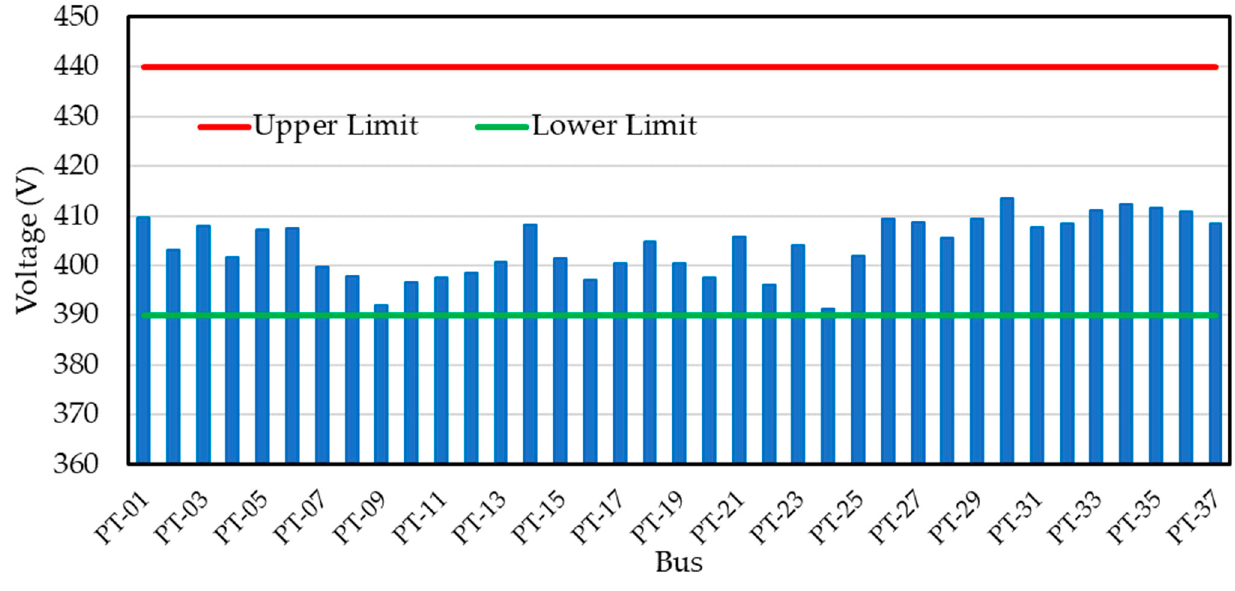
Figure 16. PV–wind–diesel system operational voltages at different load bus during the summer load . Table 13. Generated power and total losses in the PV–wind–diesel system during